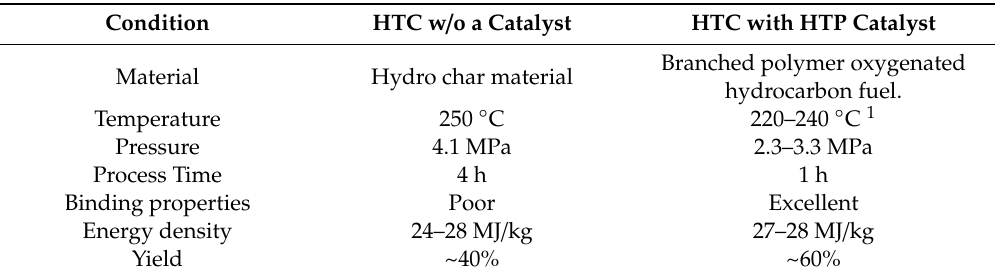
Table 1. Summary of properties of HTC without a catalyst vs. HTC with a HTP catalyst.